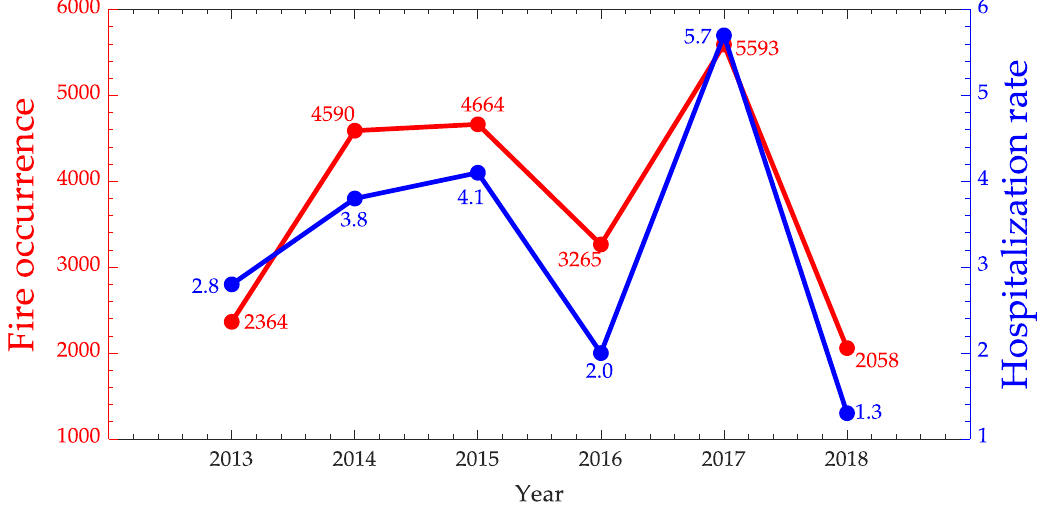
Figure 7. Time series of fire occurrences in red and Malaria hospitalization rate in blue for Maranhão